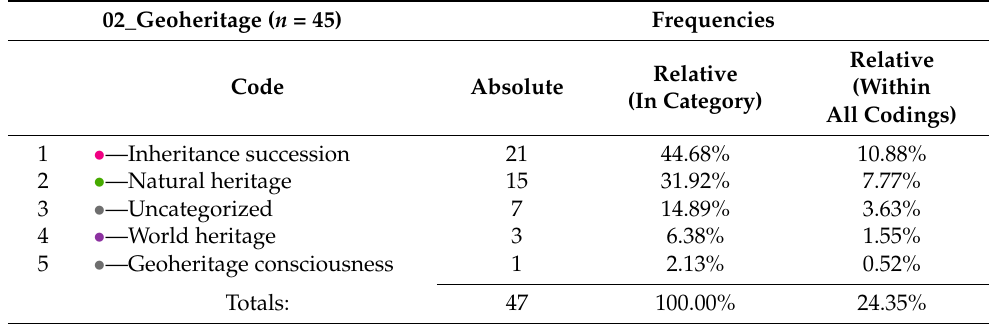
Table 3. Frequencies/distribution of codes (students’ perceptions) in the category geoheritage. 02_Geoheritage ( n = 45) Frequencies Relative Relative (Within Code Absolute (In Category) All Codings) 21 44.68%